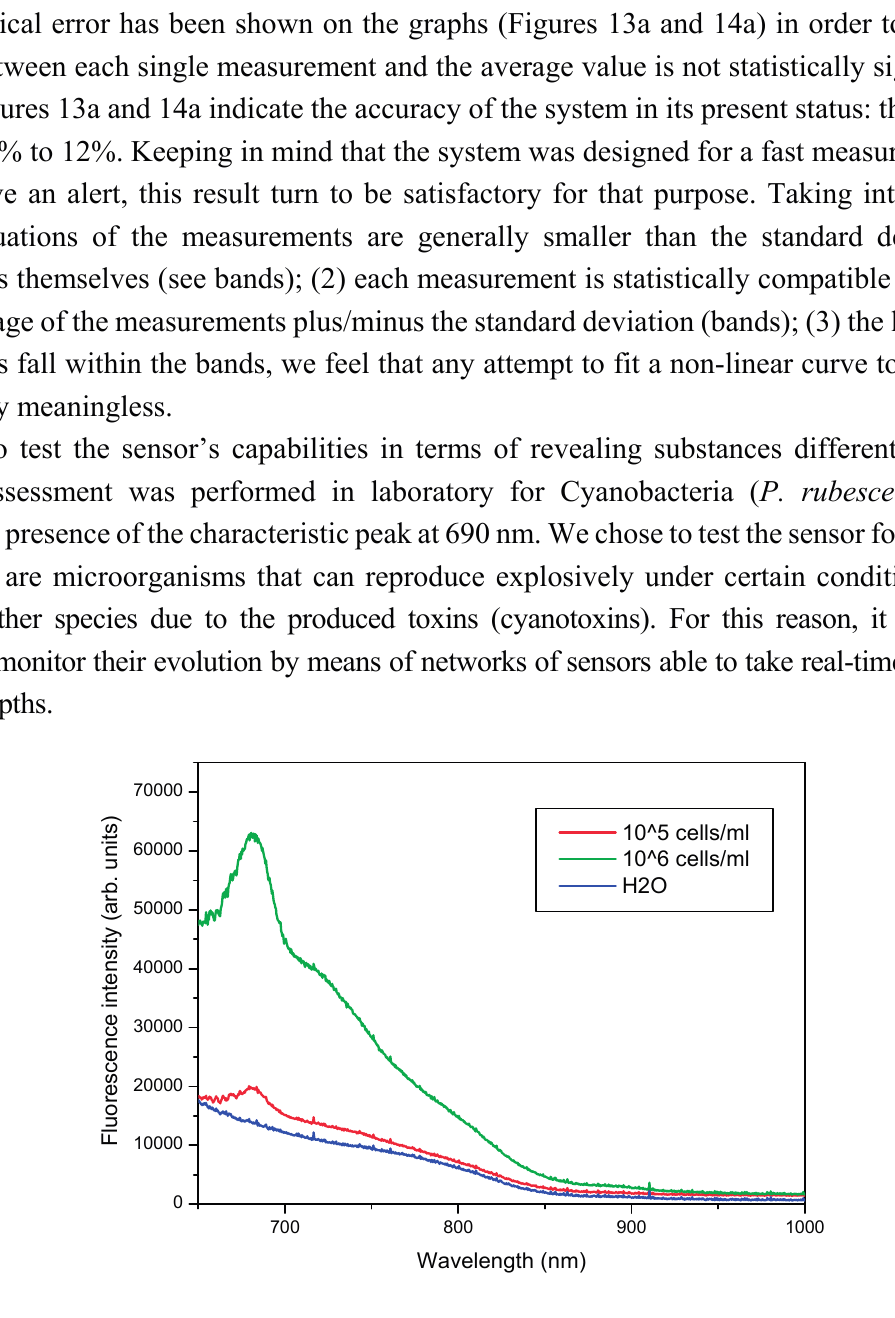
Figure 15. Cyanobacteria ( P. rubescens ) fluorescence